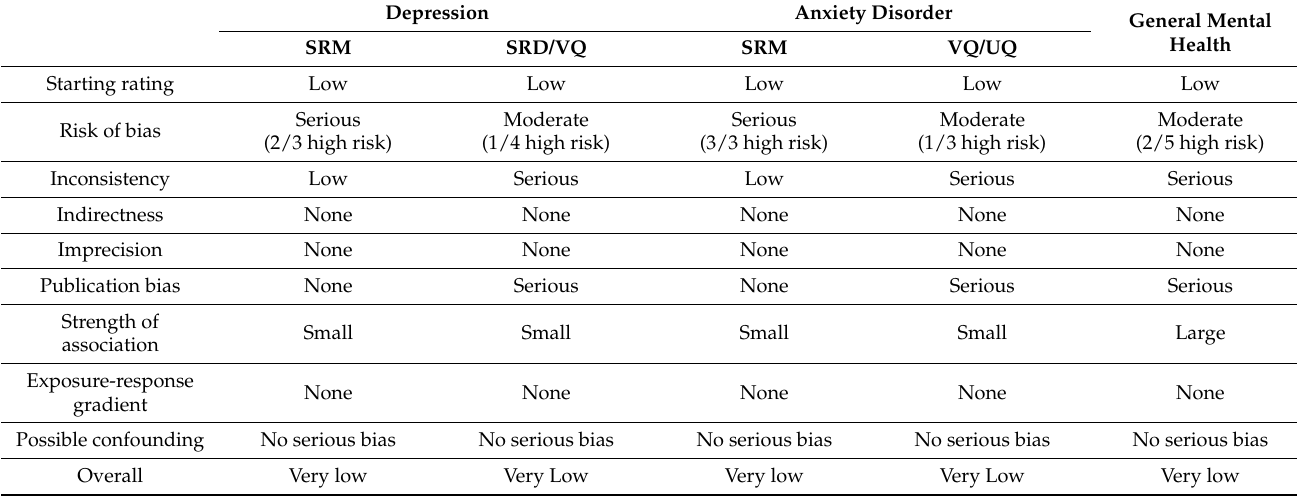
Table A5. Quality of evidence